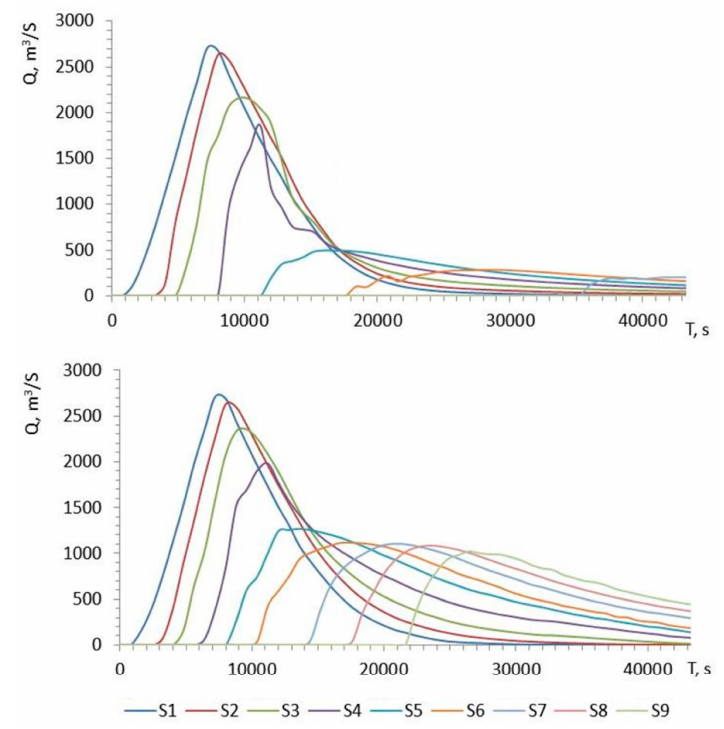
Figure 6. Attenuation and translation of the flood hydrograph as the flood wave propagates downstream in: Scenario A ( top ); and Scenario B ( bottom ). Results for n = 0.03 m − 1/3 ·s.